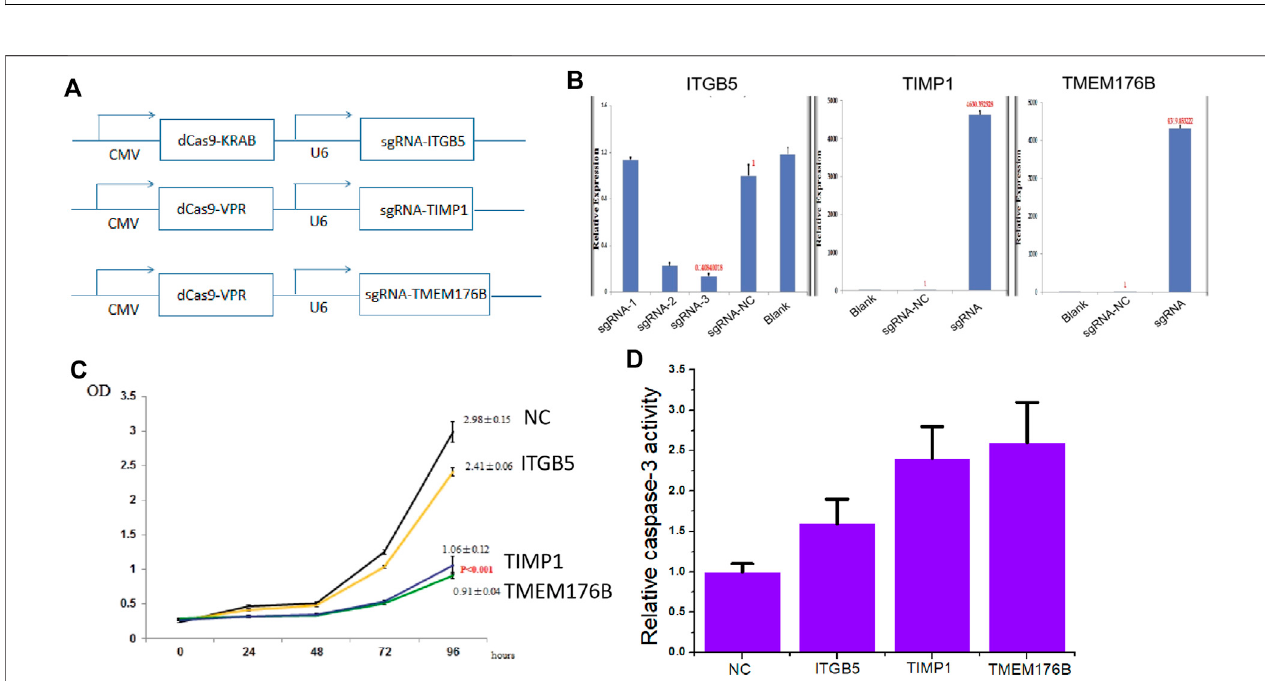
FIGURE2| TheeffectsofknockdownofITGB5oractivationofTIMP1andTMEM176Bexpressiononcellproliferationandapoptosis. (A) VectormapsofCRISPR- KRAB and CRISPR-VPR plasmidsconstructed inthiswork. (B) LNCapcellsweretransfected byCRISPRior CRISPRa systemsand geneexpression wascon fi rmedby real-timePCR. (C) MTTassaysrevealedthatknockdownofITGB5oractivationofTIMP1andTMEM176BexpressioninhibitedthegrowthrateofLNCapcells. (D) ELISA assays revealed that knockdown of ITGB5 or activation of TIMP1 and TMEM176B expression increased the apoptosis rate of LNCap cells.